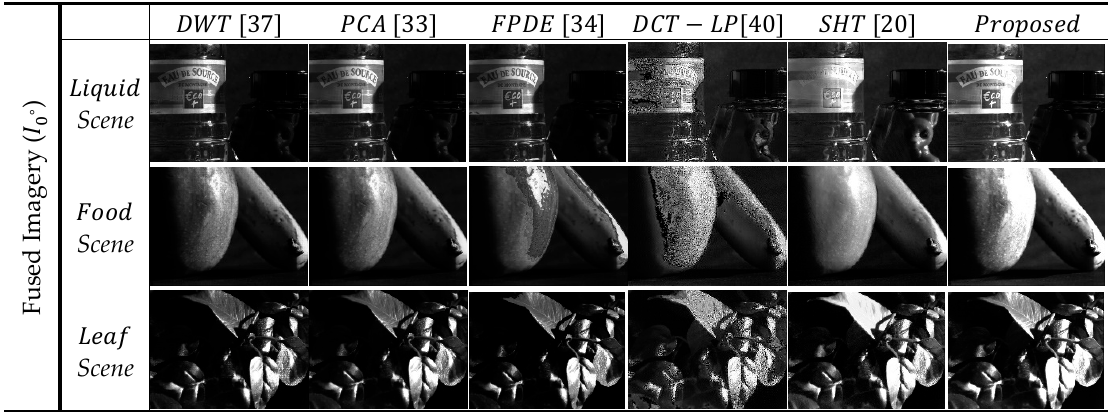
Figure 8. Samples of results of fusion methods across multiple bands at 0 ˚ polarimetric orientation.